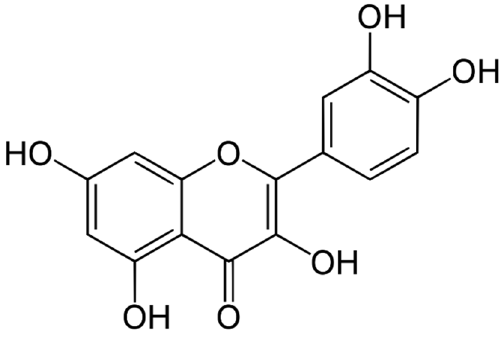
Figure 1. Chemical structure of quercetin (QRC).